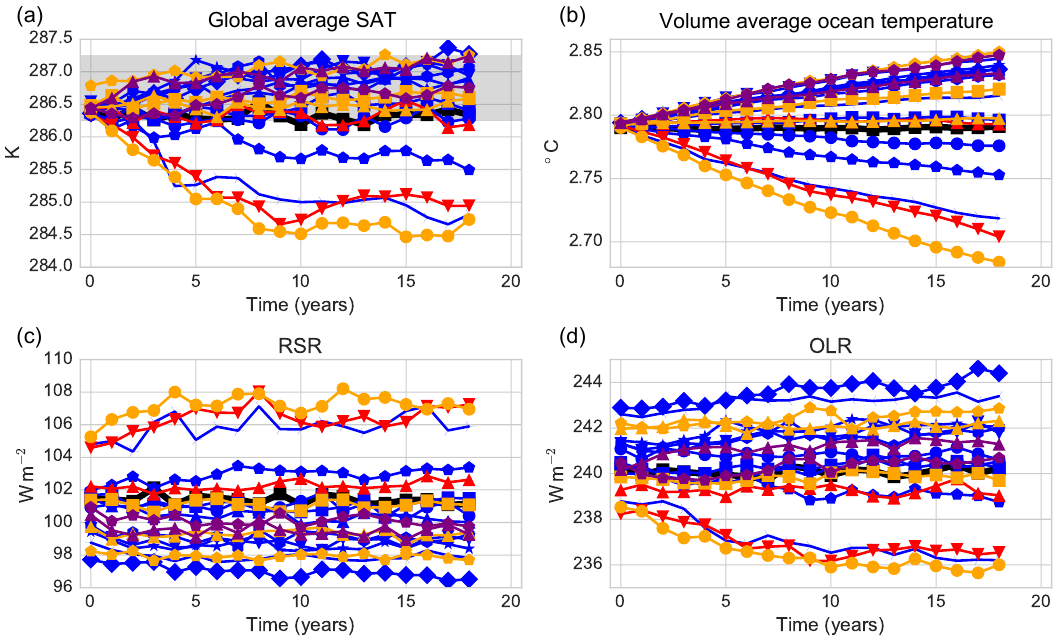
Figure 7. Time series, from control ocean–atmosphere simulations, of annual-average global-average 1.5m temperature (a) , mean volume average ocean temperature (b) , RSR (c) and OLR (d) . Colours and markers as in Fig. 1 with standard configuration shown as thick black line. Gray shading on (a) shows uncertainty range for pre-industrial global-average air temperatures from Williamson et al.